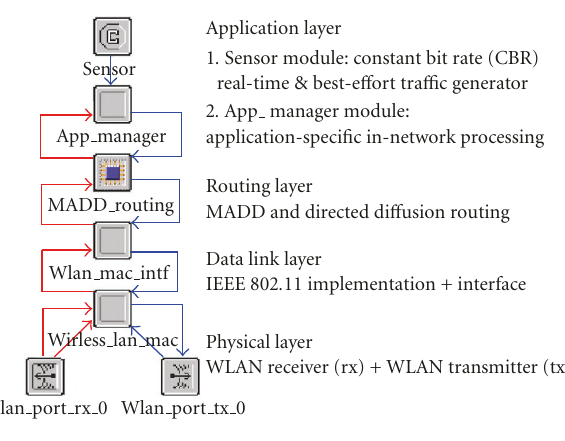
Figure 9: Sensor node